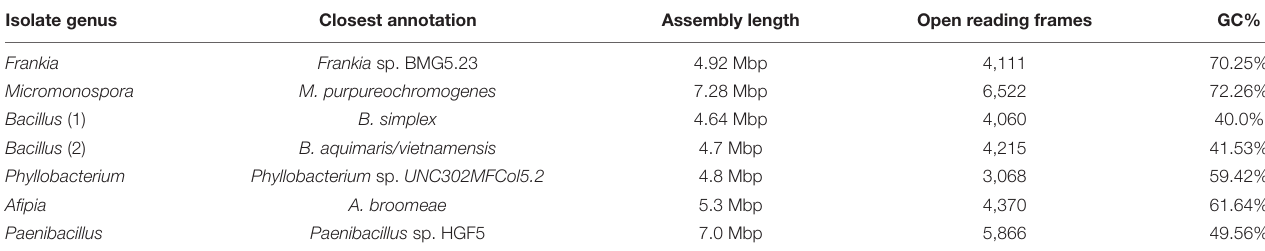
FIGURE 6 | (A) Plot of metagenomic contigs larger than 5 kbp produced by the mmgenome R Package. The seven dominant genomes that were binned using the mmgenome R package are labeled with their annotated genus. The purple and black cluster in the center of the image are contigs derived from C. glauca DNA. (B) Normalized genome coverage of genome bins. Reads from each of the three sampling sites were aligned to the co-assembled contigs. SAMtools was used to sort and index the coordinates of the aligned reads and Picard MarkDuplicates was used to remove duplicate reads with identical coordinates. Bedtools was then used to calculate coverage per contig per site. Coverage values were normalized by millions of reads per data set and the relative amount of plant DNA that comprised each data set. TABLE 1 | General assembly characteristics of each binned